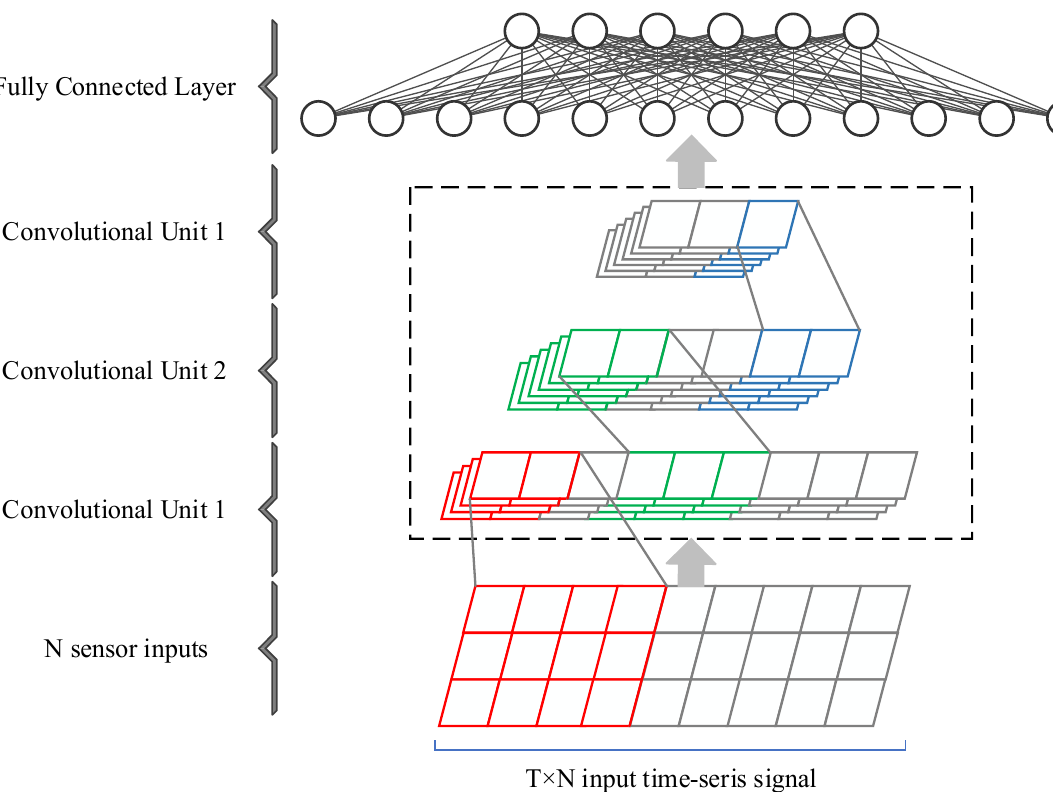
Figure 5. Main architecture of the 1D-CNN network.